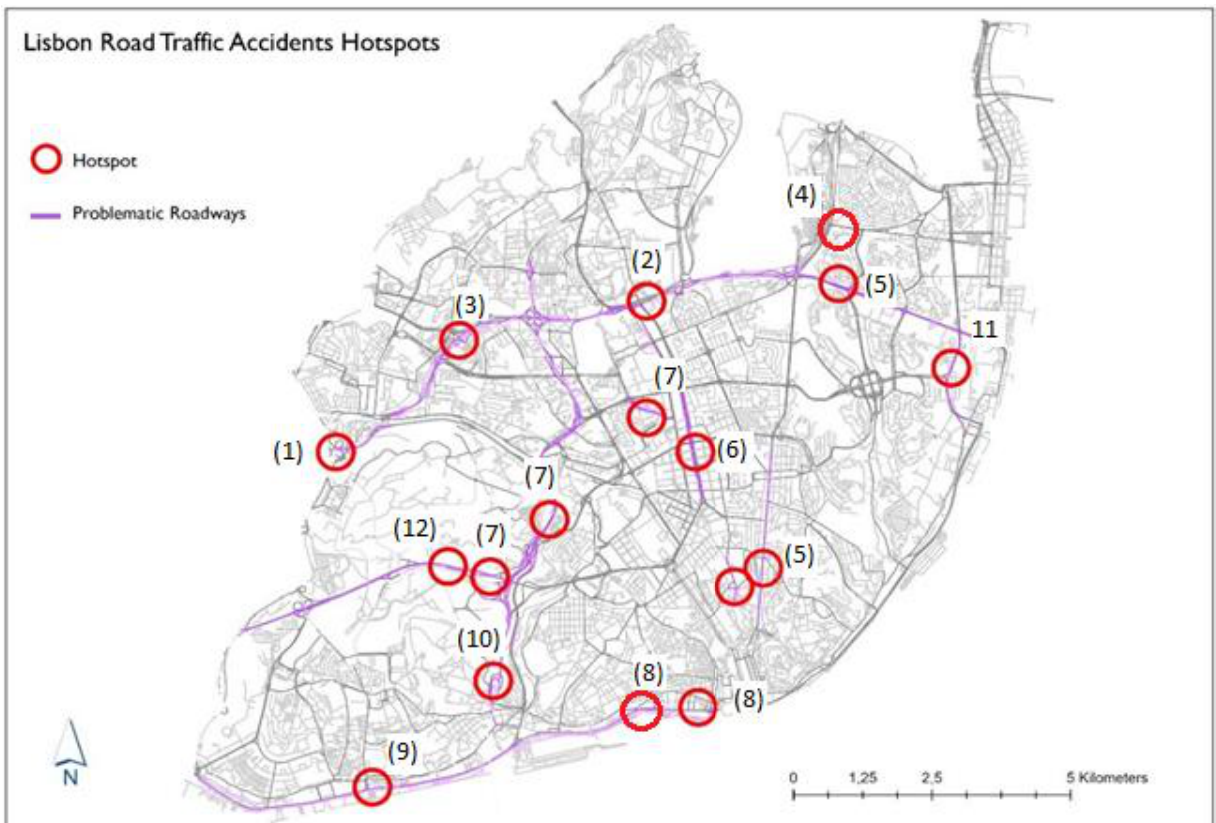
Figure 7. Lisbon Road traffic Accidents Hotspots and problematic roadways.